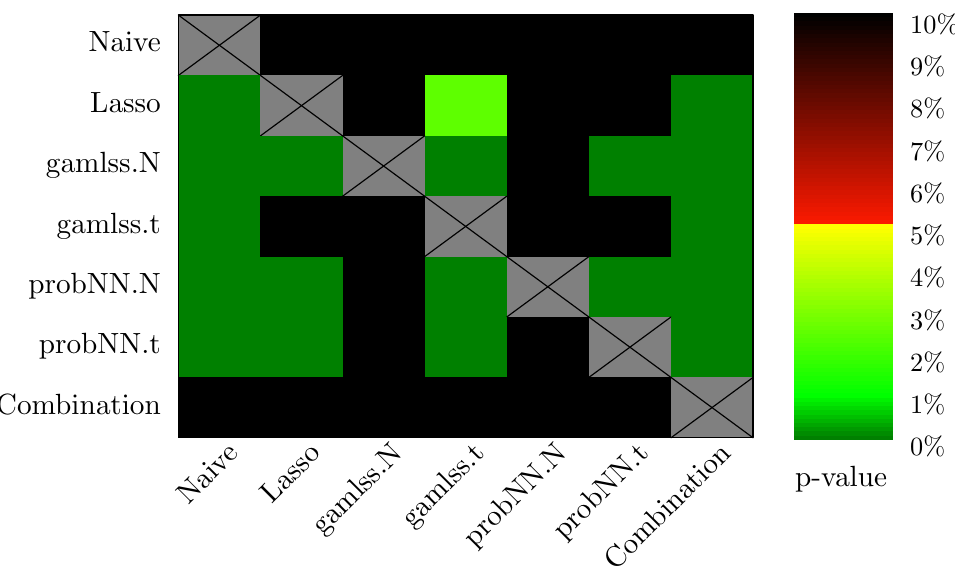
Figure 9. Results of the Diebold–Mariano test. The plots present p -values for the CRPS d , qh loss—the closer they are to zero ( → dark green), the more significant the difference is between forecasts of the x -axis model (better) and forecasts of the y -axis model